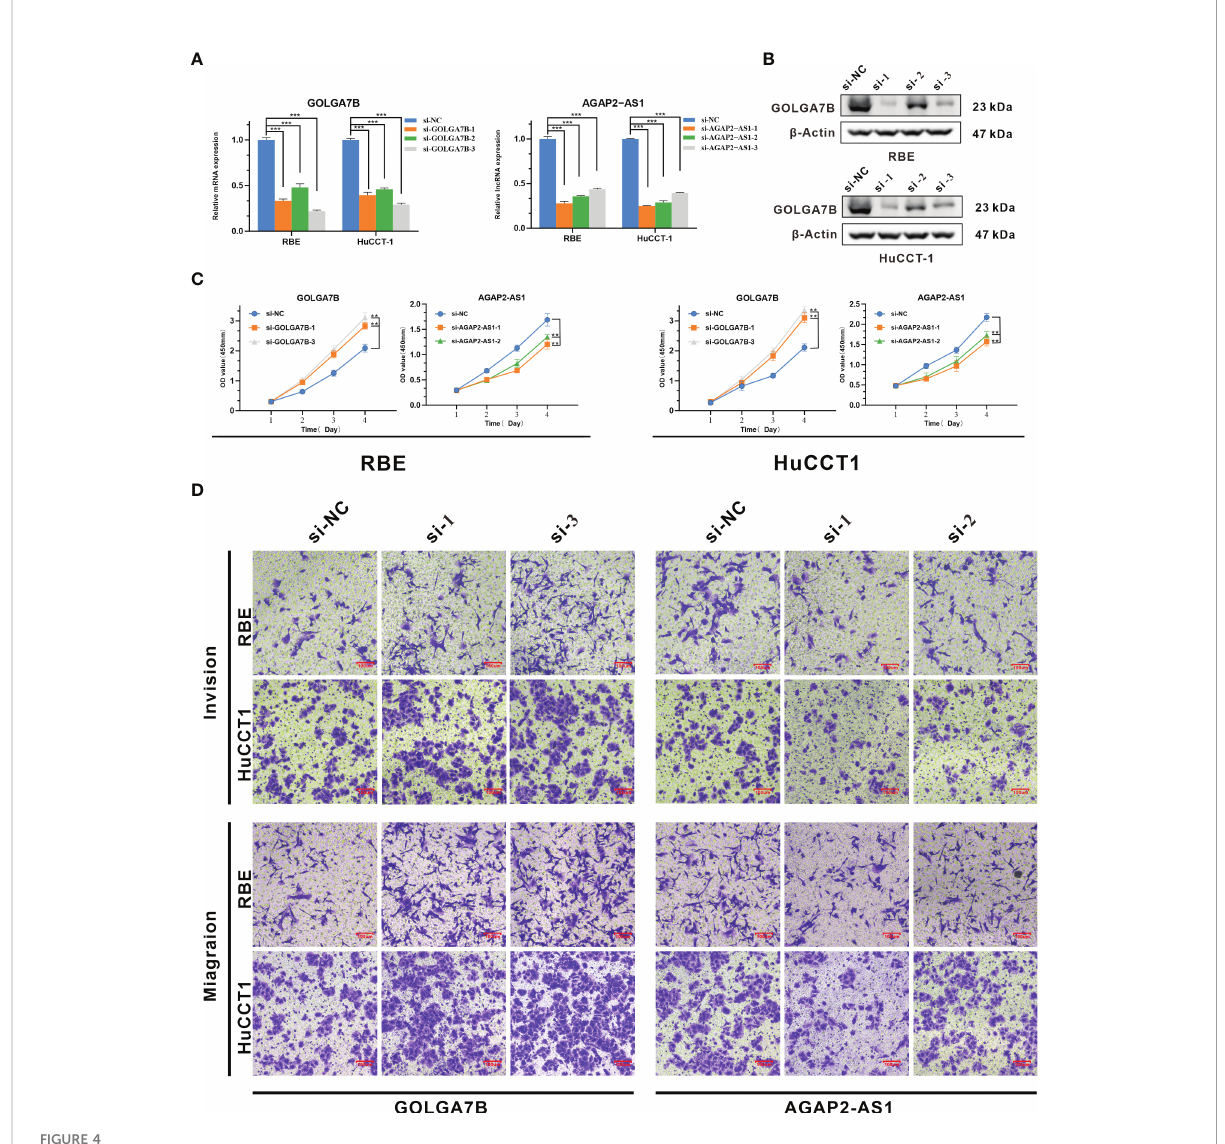
FIGURE 4 Identi fi cation of the biological functions of GOLGA7B and AGAP2 − AS1 in CCA. (A) Knockdown of GOLGA7B and AGAP2 − AS1 in RBE and HuCCT-1 cells was con fi rmed at the mRNA level by qRT-PCR. (B) Knockdown of GOLGA7B in RBE and HuCCT-1 cells was con fi rmed at the protein level by Western blotting. (C) The CCK-8 assay veri fi ed the proliferation of RBE and HuCCT-1 cells after GOLGA7B and AGAP2 − AS1 depletion. (D) Transwell assays were performed to measure the migration and invasion capabilities of RBE and HuCCT-1 cells after GOLGA7B and AGAP2 − AS1 depletion. ** P <0.01; *** P